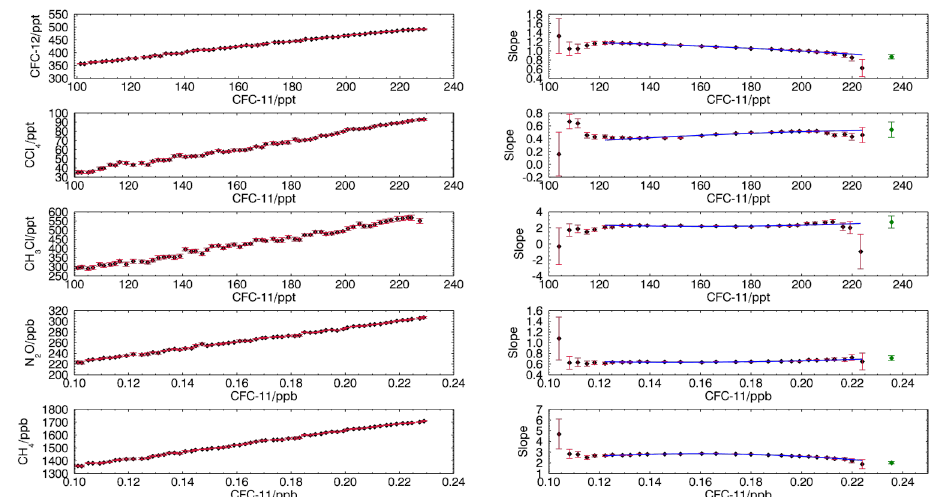
Figure B20 Correlations between the volume mixing ratios of CFC-12, CCl 4 , CH 4 , CH 3 Cl and N 2 O and CFC-11 for the data from the southern hemisphere during the stratospheric winter of 2009. Left panels: The mean correlation profile. Each point represents the mean of the VMR in a window of 2 ppt of CFC- 11. The error on these points is the standard deviation of the data within each 2 ppt window. Right panels: The local slope of data in an 80 ppt of CFC-11 window. The error on the points is the fitting error of this fit. The blue line is a second degree polynomial fit to the local slopes. The green point is the extrapolated slope at the tropopause.